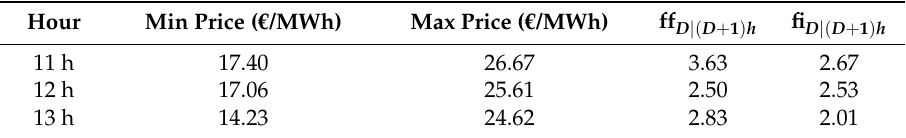
Table 1. Results of PPFMCP model 1.